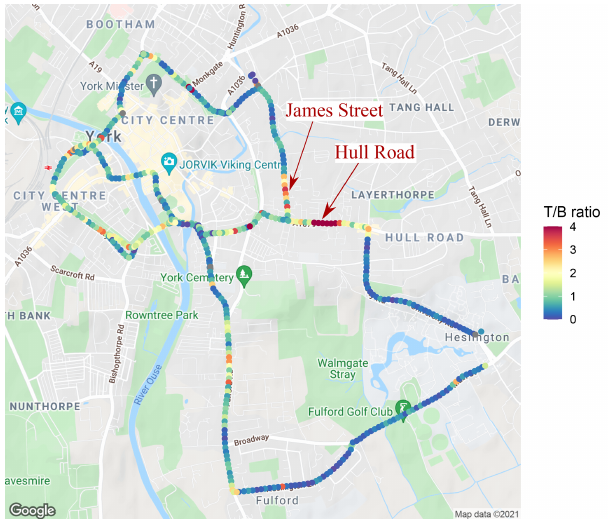
Figure 9. A spatial map showing the toluene-to-benzene (T / B) ratio calculated using ordinary least squares (OLS) regression (© Google). The ratio was calculated using toluene and benzene measurements made during all 30 repeat drives around York, and each point represents the ratio for a 30m segment of road. Elevated ratios on Hull Road and James Street are labelled with red arrows. Visualised by the ggmap R package (Kahle and Wickham,